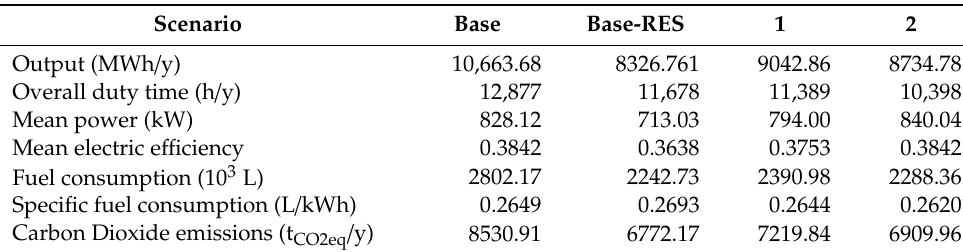
Table 6. Overall gen-set performance.